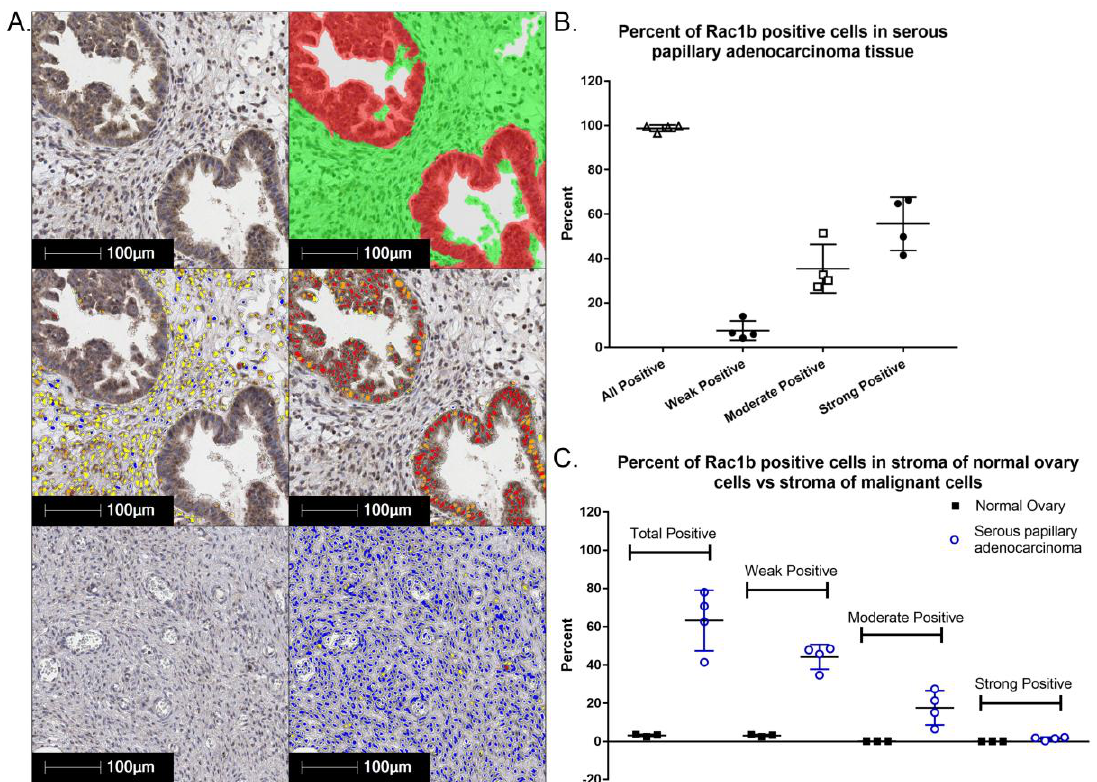
Figure 5. The constitutively active Rac1b splice variant is overexpressed in ovarian cancer. Ovarian cancer tissue microarrays were stained for Rac1b, a constitutively active Rac1 splice variant. Slides were imaged using an Aperio slide scanner and analysis was performed using HALO software. ( A ) Top panel: Malignant tissue stained with DAB for Rac1b. Analysis to identify tumor cells (red) and stromal cells (green). Middle panel: Quantification of the amount of Rac1b expression in tumor cells (right) vs. stromal cells (left) in malignant tissue. Blue-no staining, yellow-weak staining, orange-moderate staining, red-strong staining. Bottom panel: Quantification of Rac1b expression in stromal cells in normal ovary tissue, colors as for middle panel. ( B ) The majority of serous papillary ovarian adenocarcinoma cells were moderately to strongly positive for Rac1b, while stromal cells were weakly positive. ( C ) Quantitative comparisons of normal ovary tissue and serous papillary ovarian adenocarcinoma tissue evidences an elevated expression of Rac1b in the stromal cells adjacent to the malignant tumor cells relative to normal tissue.